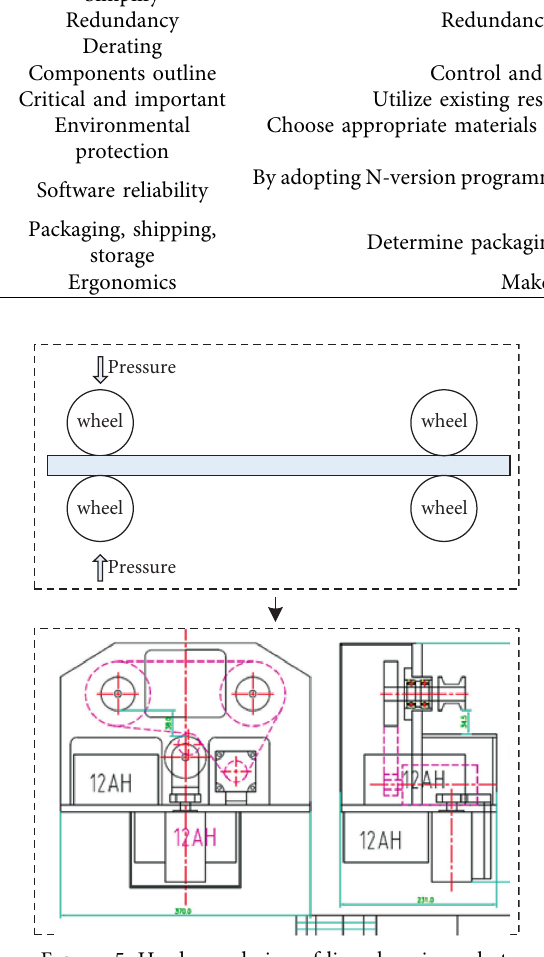
Figure 5: Hardware design of line changing robot.